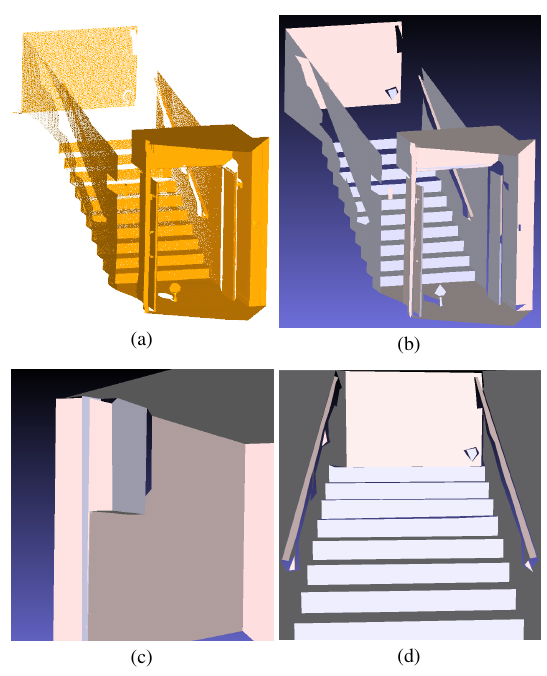
Figure 14. 3D reconstruction of a staircase. (a) LiDAR 3D point cloud, (b) mesh model obtained, (c) zoom on a box, (d) zoom on banisters and their